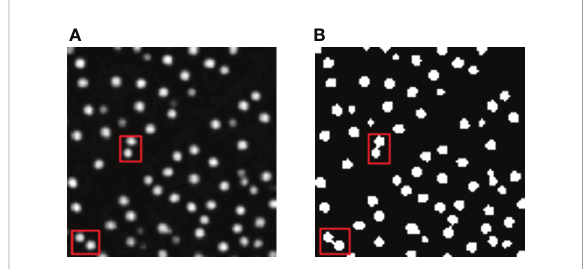
FIGURE 12 Cases of misjudgment. (A) The segmentation result of Ipp Net model; (B) The result after fi ltering and optimization. The red box is the part of the image optimized to cause the adhesion of pigment